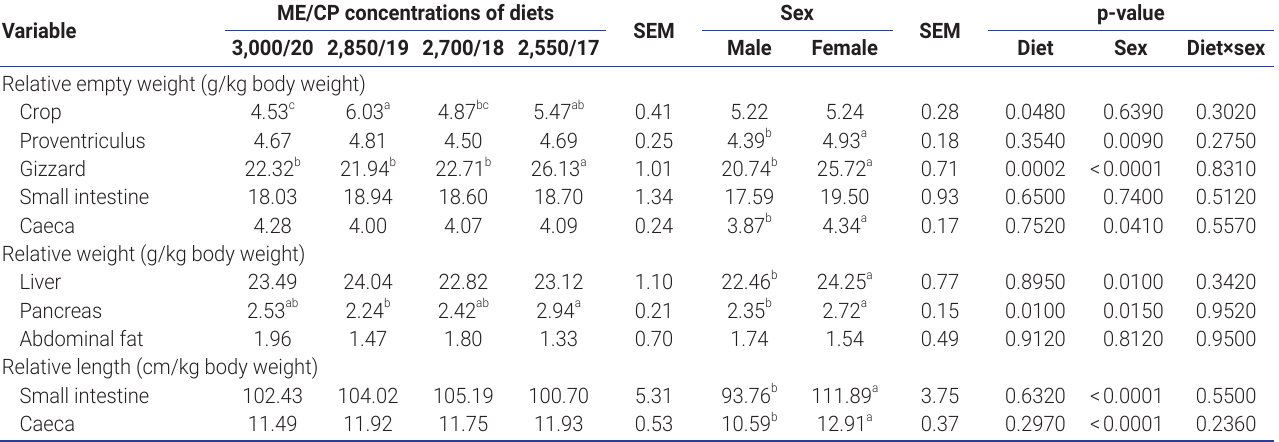
Table 4. Organs size of 12-week-old of Mexican Creole chickens fed diets with different concentrations of ME and CP ME/CP concentrations of diets Variable Relative empty weight (g/kg body weight) Crop Proventriculus